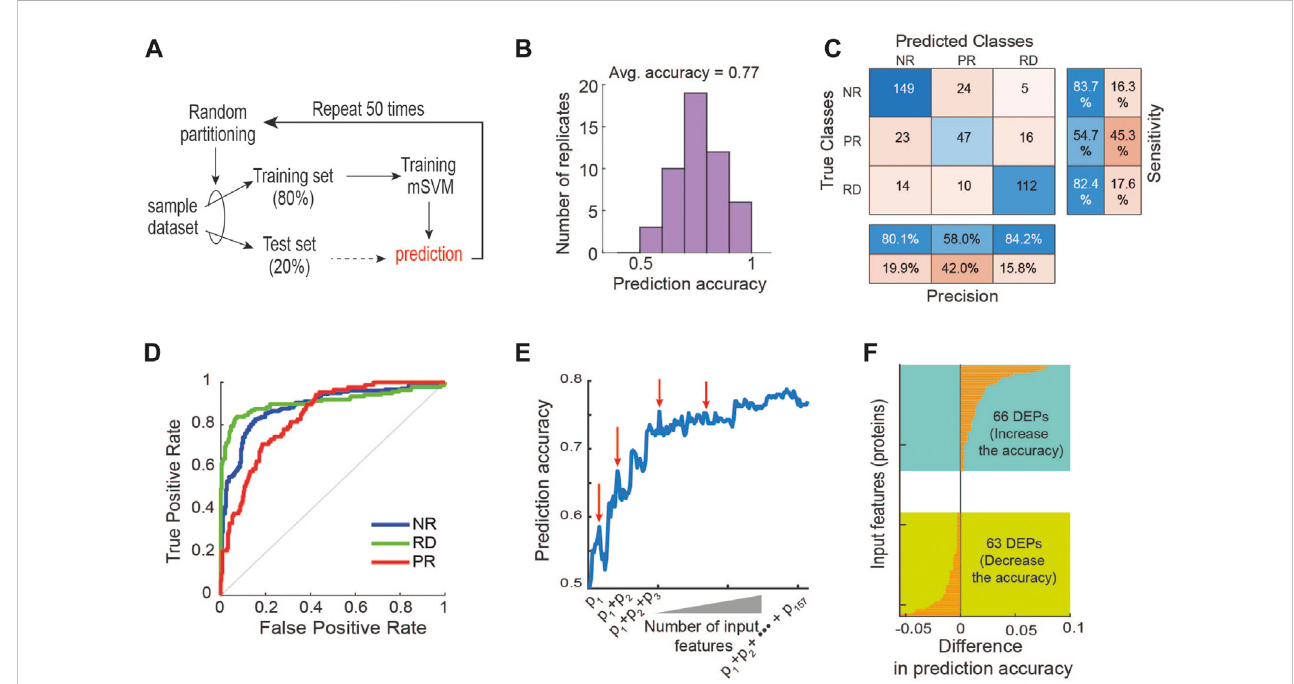
FIGURE 3 Machinelearning-basedpredictionofresponseto17-AAG. (A) Amachinelearningpipelineutilizingtherepeatedholdoutmethodfortrainingandtesting withanmSVMmodel(seeMaterialsandMethods). (B) Distributionofpredictionaccuracyperformanceacross50modelreplicateruns. (C) Performanceofthe mSVM classi fi er using all 157 DEPs as input features, summarized in a confusion matrix. (D) Receiver operating characteristic (ROC) curves of the mSVM classi fi er for the RD, NR and PR response groups. (E) Impact of input feature space modulation on model prediction accuracy. Adding speci fi c input features may worsen model performance, indicated by the red arrows. (F) Difference in the prediction accuracy when a new input feature is added to the training